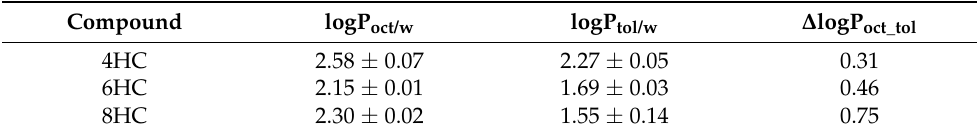
Table 4. Lipophilicity of curcumin and hydrocurcumin analogs in two different biphasic (octanol— water: logP oct/w and toluene—water: logP tol/w ) systems. Data represent average ± S.E.M from